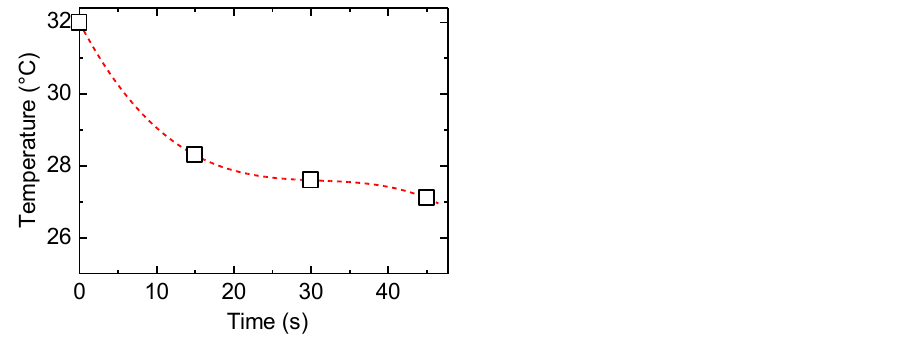
Figure 8. Change in surface temperature as a function of time for PAZ/Hb accompanied by heat discharge after heat treatment.